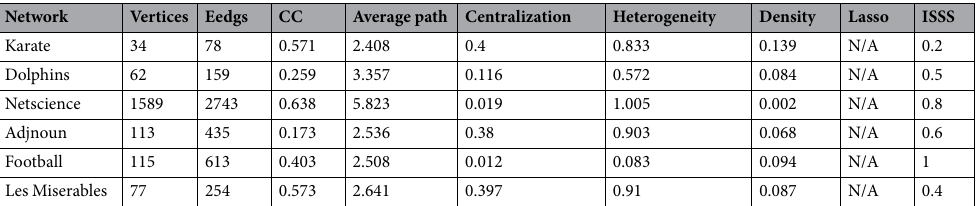
Table 2. Minimum data for achieving at least 0.95 AUROC in combination with several real networks. CC stands for clustering